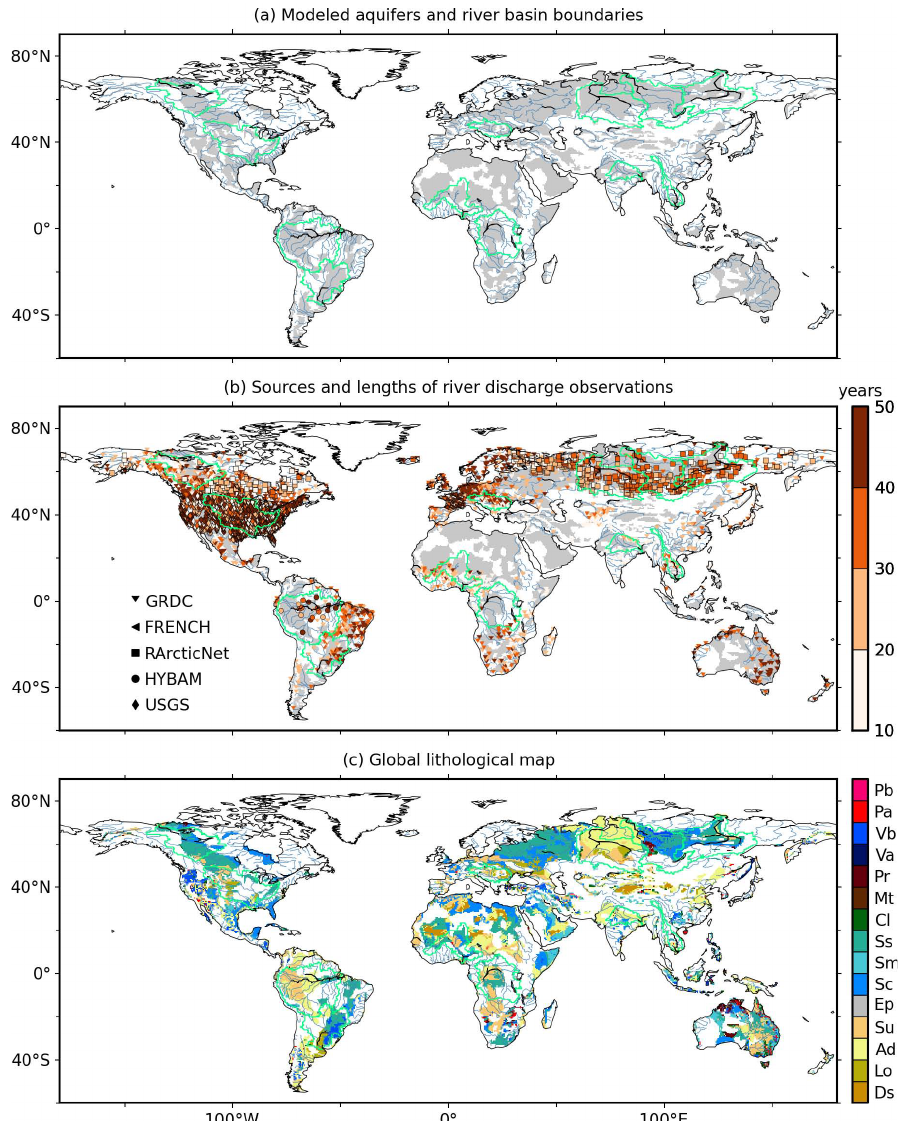
Fig. 2. (a) Modeled aquifers and river basin boundaries, (b) sources and time lengths of the in-situ gauging stations with the aquifers defined at 0.5 ◦ in gray-shaded zones, and (c) global lithological map of D¨urr et al. (2005) over these aquifers. The green contours delineate the major river basins of the